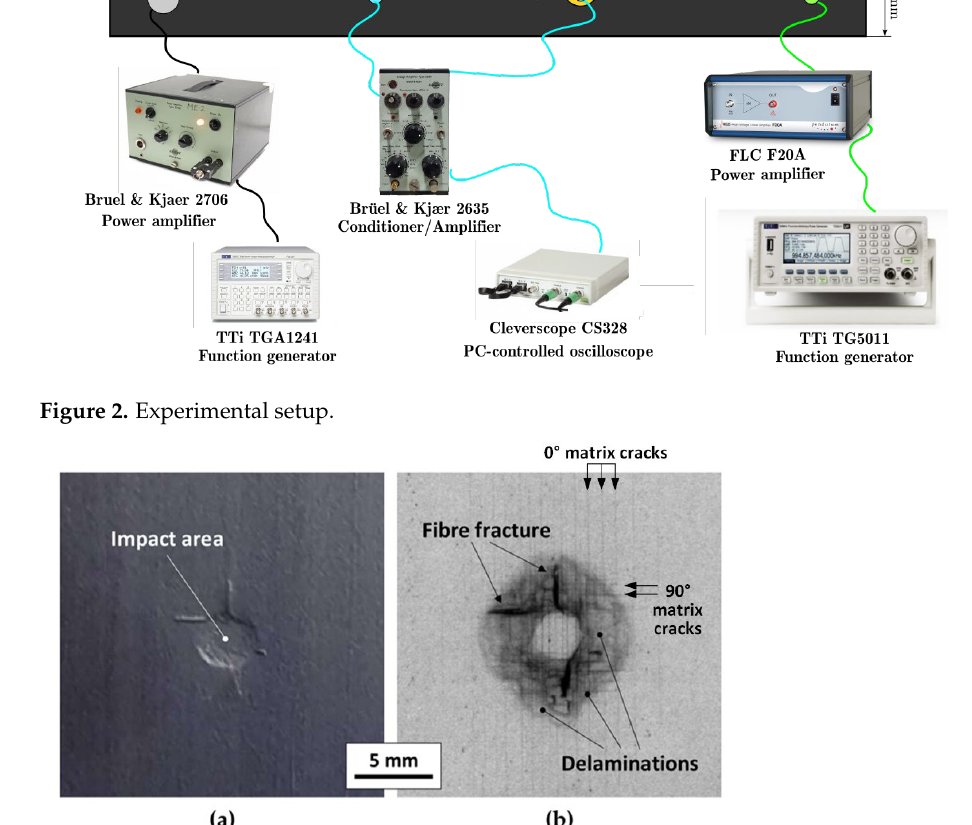
Figure 3. Surface indentation ( a ) and radiographic image of internal damage ( b ) induced by the low- velocity impact.